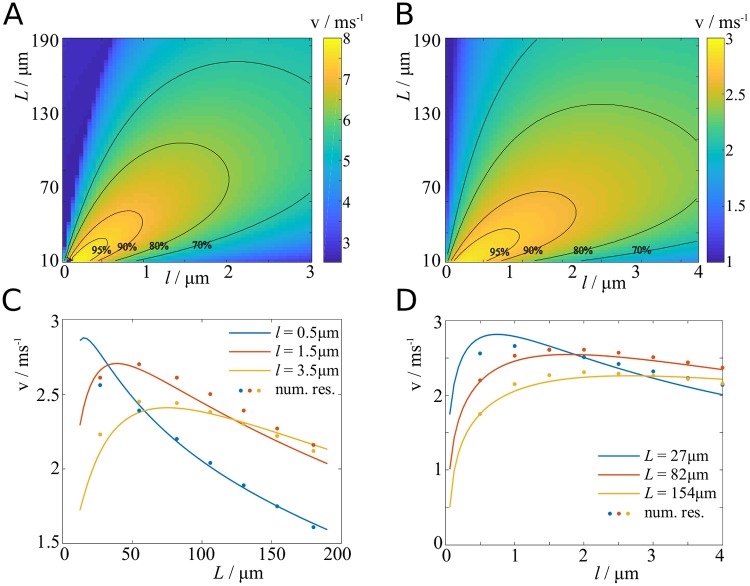
Velocity dependence on node length and internode length.A: Propagation velocity plotted against node length and internode length. Contours indicate percentages of maximum velocity. (Scenario D with standard parameters.) B: Same as A, with fitted parameters. C: Propagation velocity as function of internode length (scenario D with fitted parameters), and comparison with numerical results from biophysical model. D: Propagation velocity as function of node length, and comparison with the model by Arancibia-Carcamo et al. [24].